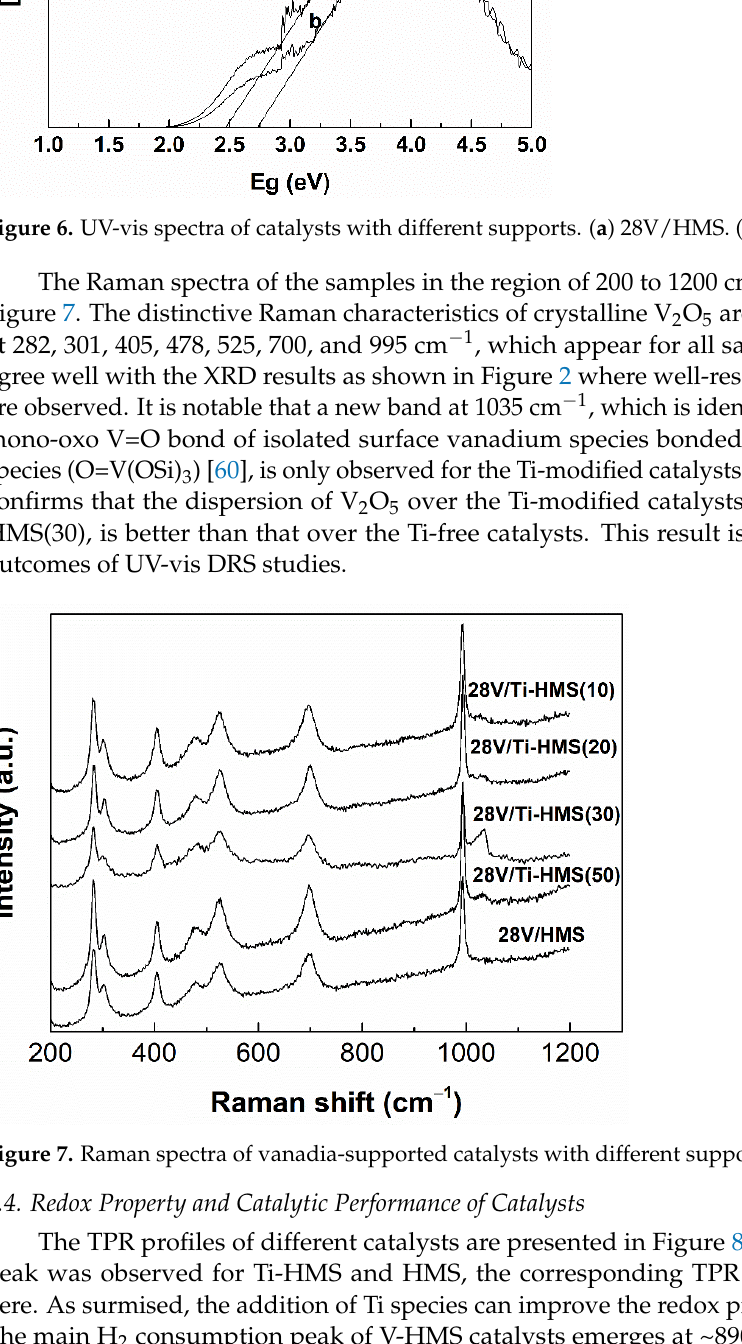
Figure 7. Raman spectra of vanadia-supported catalysts with different